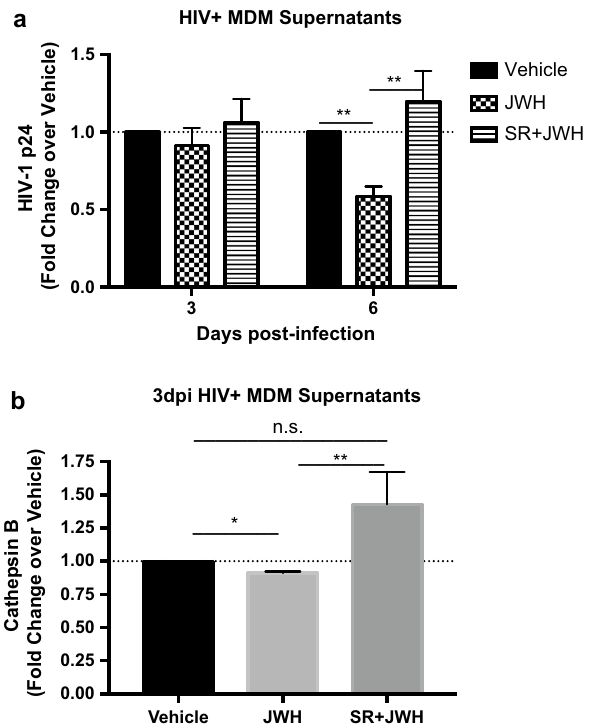
Figure 4. JWH-133 decreases HIV-1 replication and CATB secretion through CB2R activation. MDM were cultured in 24-wells plates and infected with HIV-1 ADA . After removal of residual virus, cells were treated with CB2R antagonist SR144528 (SR: 1 µM) for 1 h, followed by JWH-133 (JWH) treatment at 0.5 µM. Treatments were maintained for 6dpi, exchanging half of the media at day 3pi and repeating the co-administration protocol. HIV-1 p24 and CATB levels were measured in HIV-infected MDM supernatants using ELISA. HIV-1 p24 and CATB levels were normalized against its vehicle control per donor. ( a ) HIV-1 p24 levels in HIV-infected MDM after co-administration of CB2R ligands. This figure is representative of at least eight different donors (n = 8). ( b ) CATB levels in HIV-infected MDM after co-administration of CB2R ligands. This figure is representative of ten different donors (n = 10). Graphs are presented using the mean ± standard error of the mean (SEM). * p < 0.05, ** p <